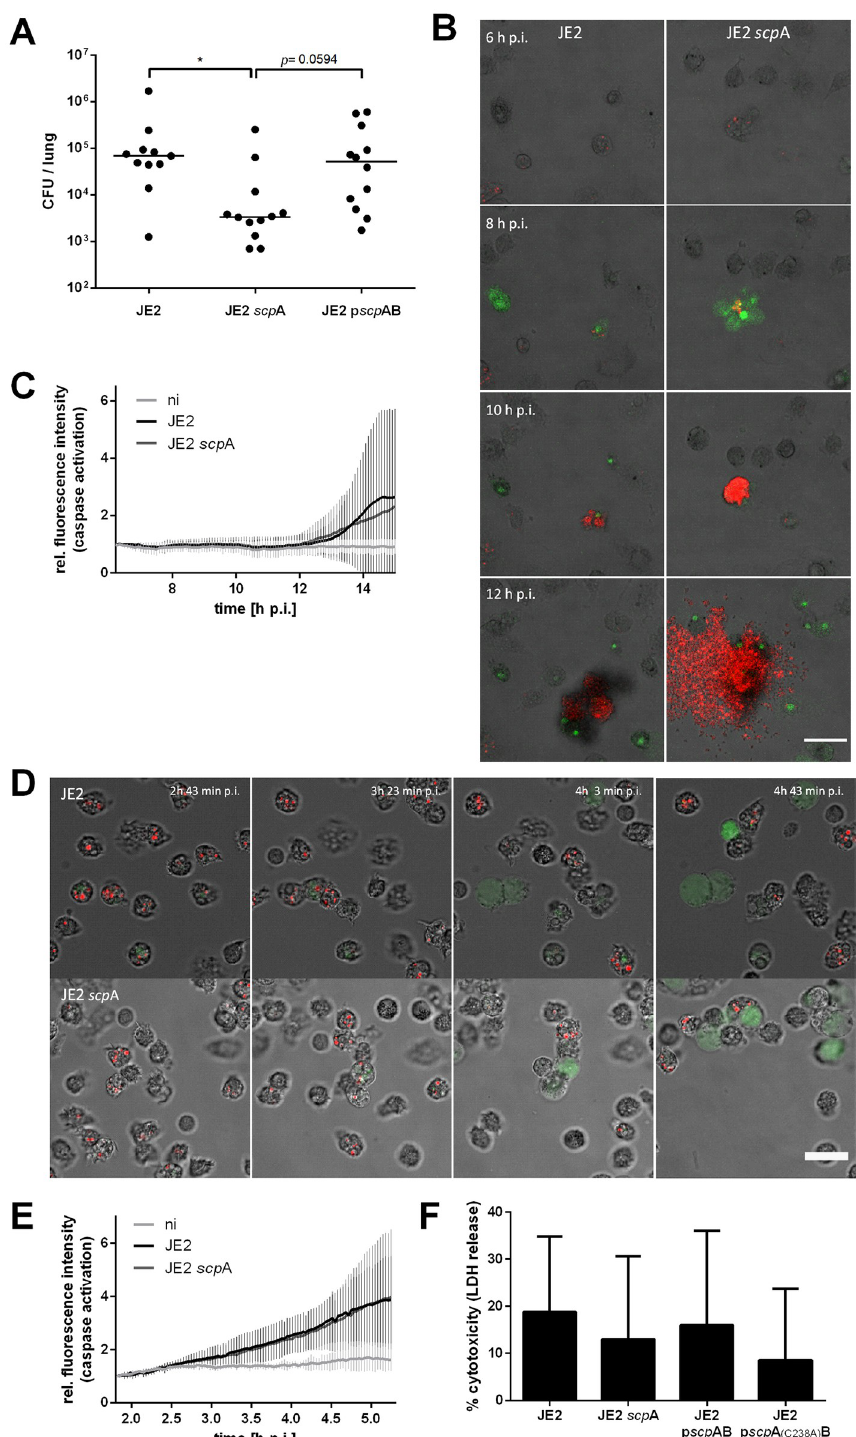
Fig 7. Effects of staphopain A loss of function in vivo and in phagocytic cells. (A) Balb/c mice were intranasally administered with wild type bacteria (JE2), scp A mutant (JE2 scp A) or complemented mutant (JE2 p scp AB) and bacterial CFUs were recovered from lung tissue 48 h p.i. by plating serial dilutions of the lysed tissue. The horizontal line represents the median of recovered CFUs from total lungs of mice, individual points illustrate the CFUs recovered from the lungs of one mouse. (B,C) Primary human M-CSF derived macrophages were infected with S . aureus JE2